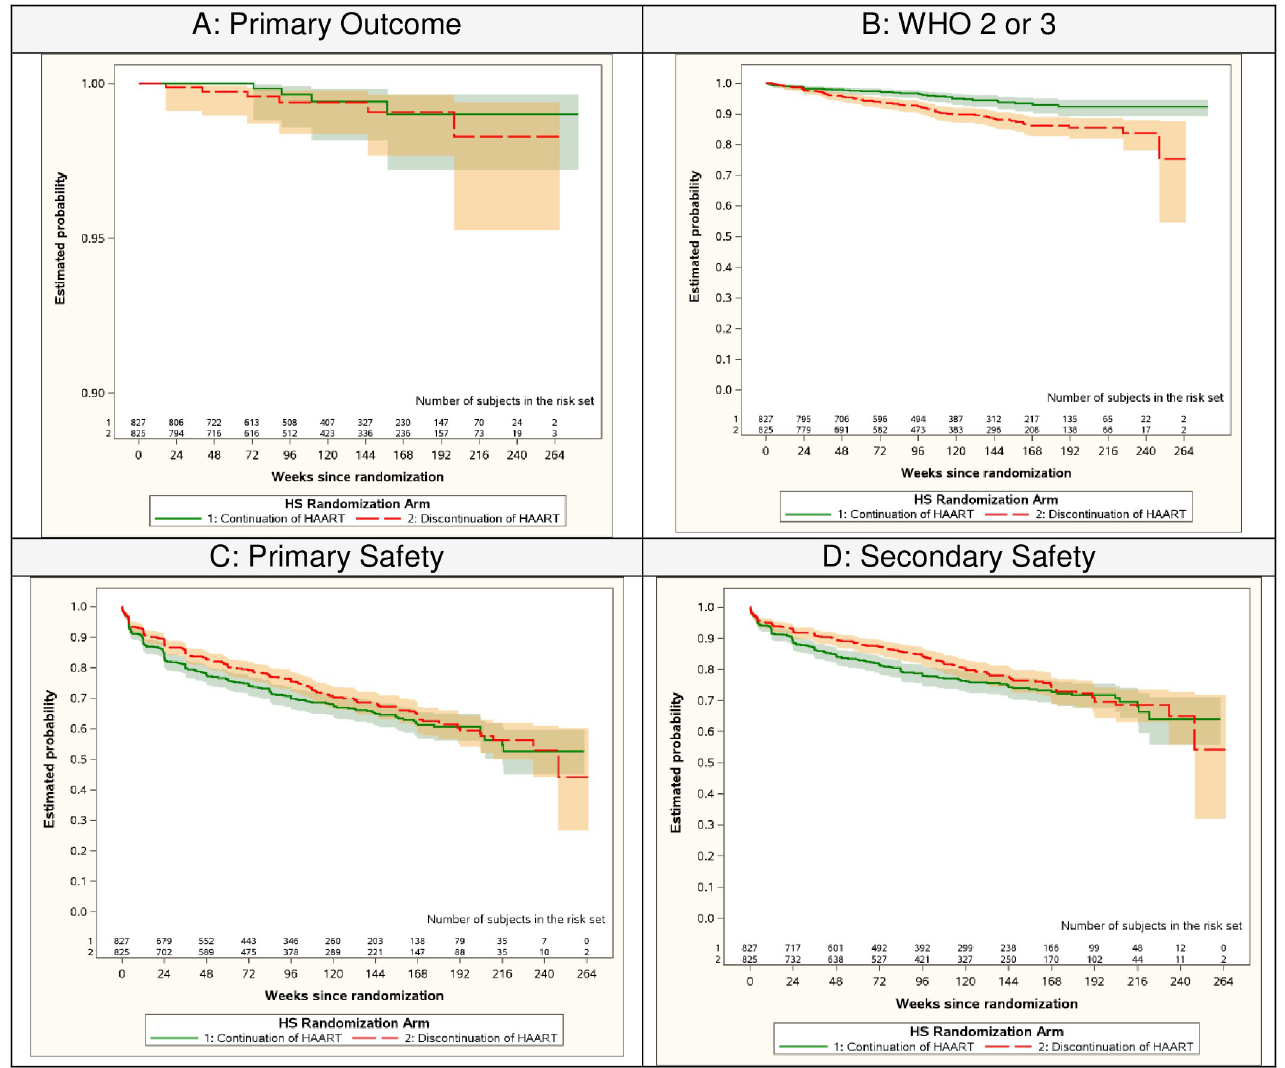
Fig 2. Survival Curvesfor the Primary and Secondary Endpoints. A) Composite endpointof the first AIDS-defining illness, seriousnon-AIDS definingcardiovascular, renal or hepaticevent or death. B) Compositeendpoint of the first WHO 2 or 3 event. C) Composite of first grade 3 or 4 sign or symptom, or grade 2,3, or 4 hematology or chemistry event. D) Compositeof the first grade 3 or 4 sign or symptom, or hematology or chemistry event.